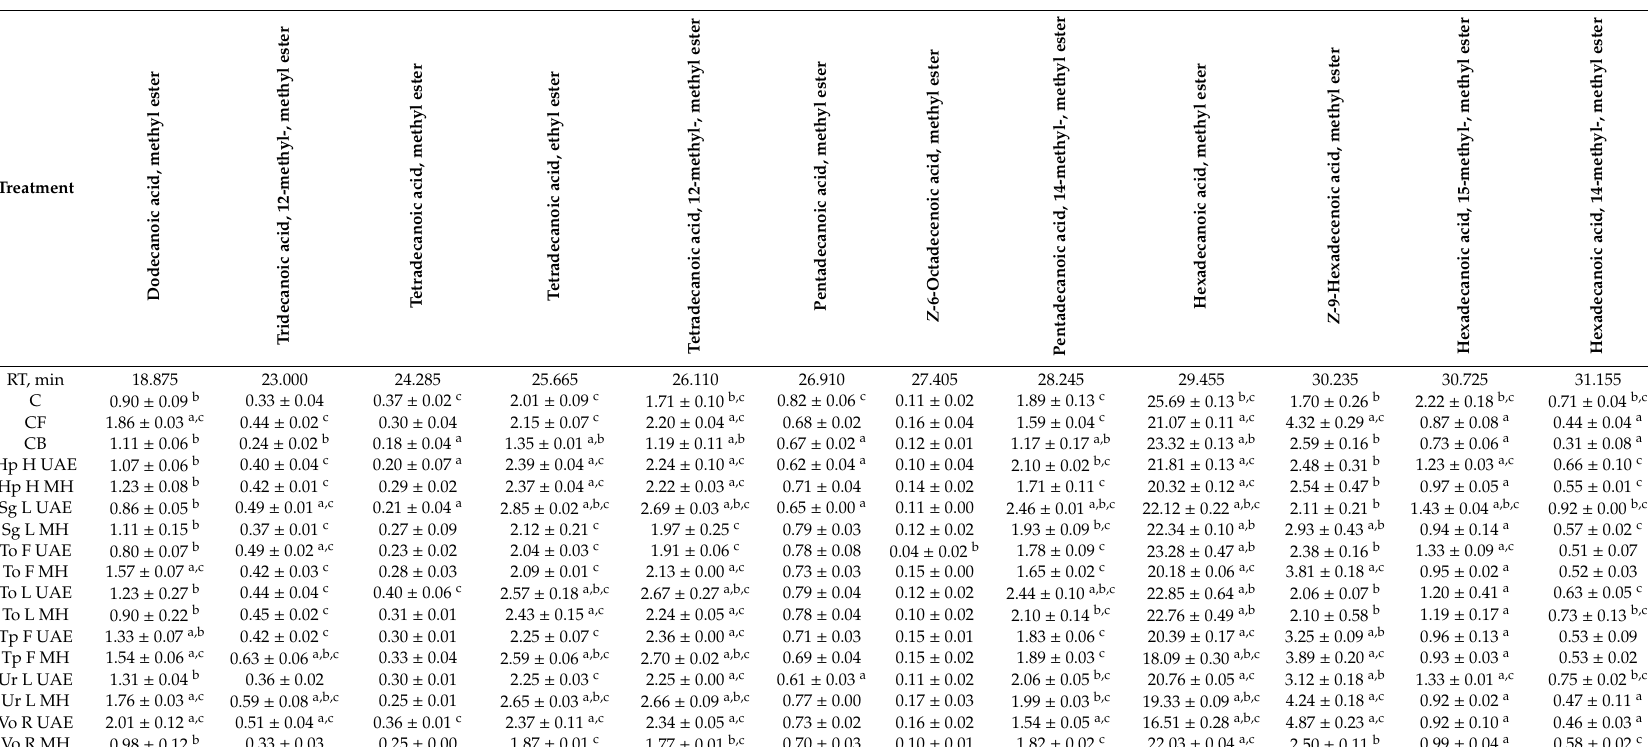
Table 6. E ff ect of the foliar application of botanical extracts on the fatty acids composition (amount of single component calculated as percent (%) of whole GC-MS chromatogram area) of celeriac roots (N = 3, mean ±